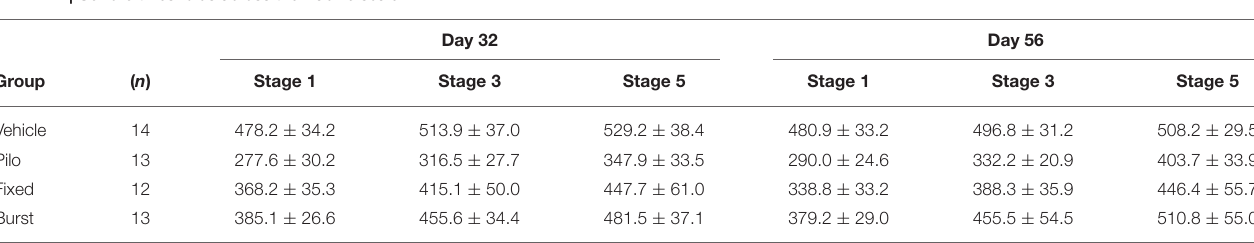
TABLE 2 | Seizure thresholds across the Racine